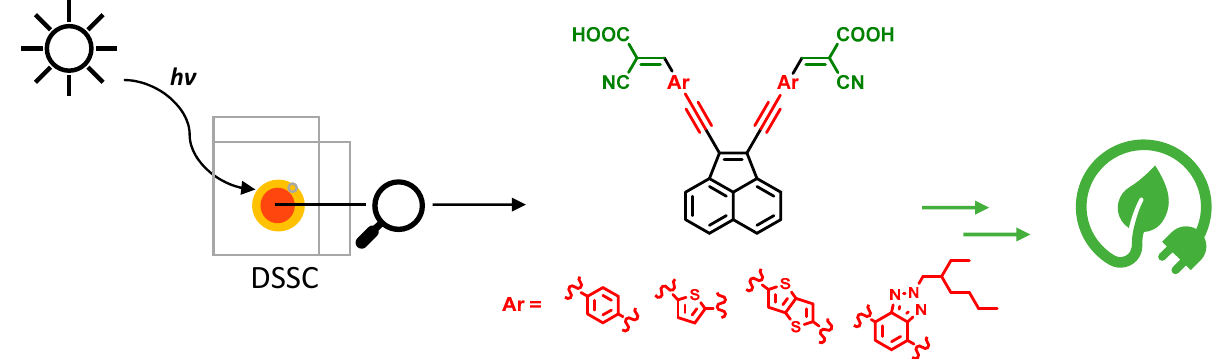
Figure 1. Schematic representation of the synthesized acenaphthylene-based organic Figure 14. Schematic representation of the synthesized acenaphthylene-based organic dyes.